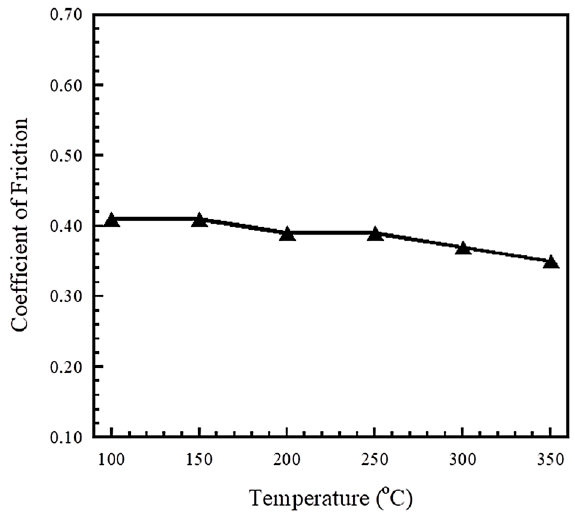
Figure 8. Coefficient of friction as a function of the temperature of F-BA-a composite.